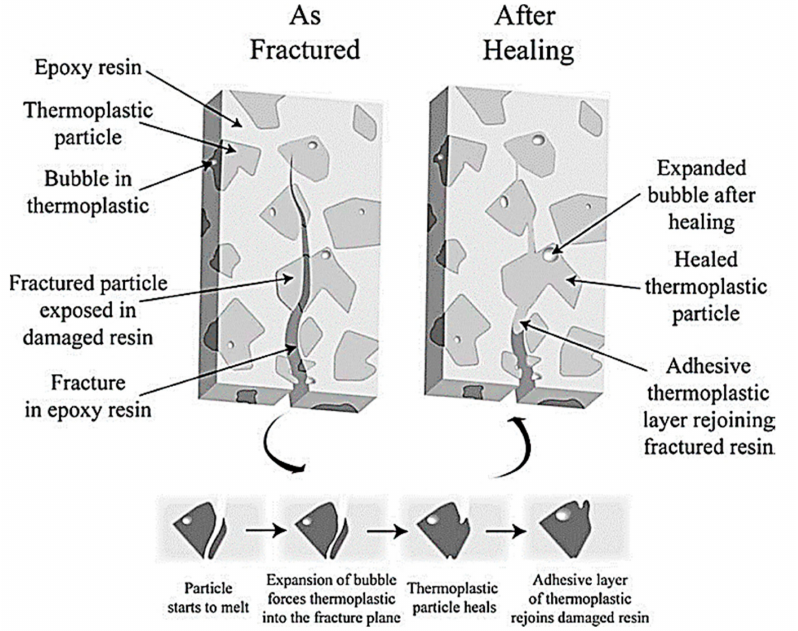
Figure 17. Schematic of healing agent delivery mechanism in epoxy-resin-containing healing agent containing particles in adhesives. EMAA = polyethylene-co-methacrylic acid. Reprinted with permission from [163]. 2009, Elsevier.